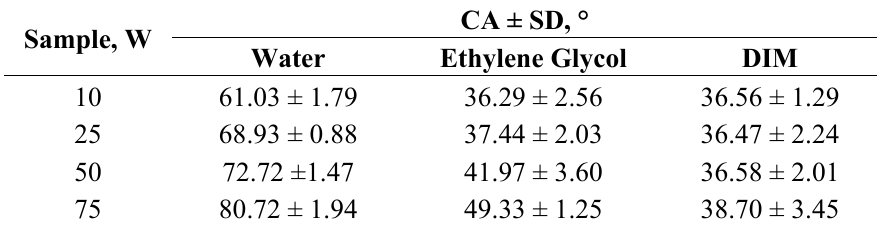
Table 4. Static CAs for pp–GT thin film surfaces. DIM,